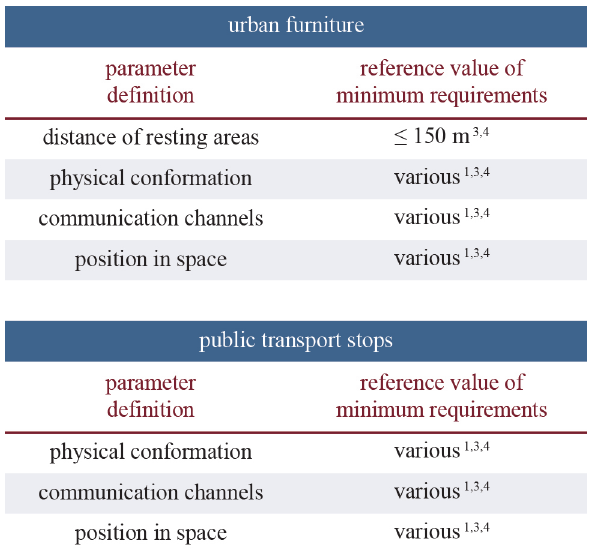
Table 5. Proposed parameters for the assess of urban furniture (top) and public transport stops (bottom). The latter define the general evaluation criteria, however multiple requirements must be addressed for the individual object (for this reason the term various was used). Sources are 1: Italian regulation, 3: literature and empirical investigation, 4: Irish National Disability